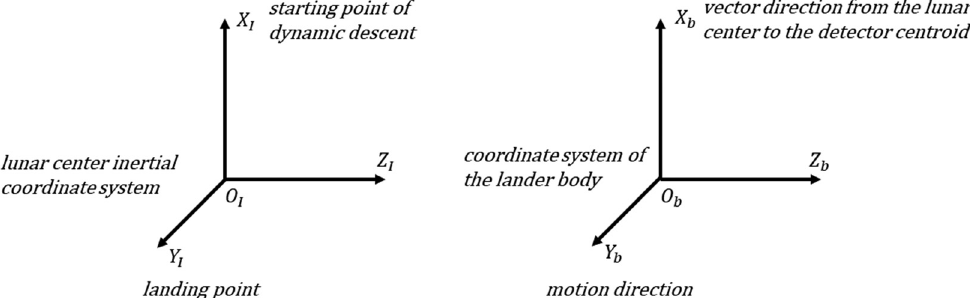
Figure 1: Coordinate